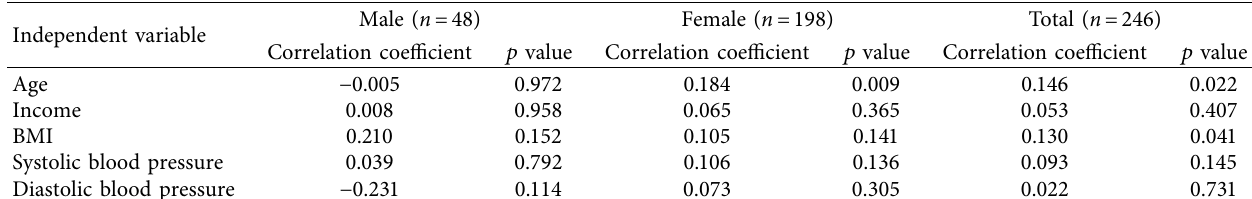
Table 2: Spearman’s rho correlation test’s results between predictor variables and pre-diabetes